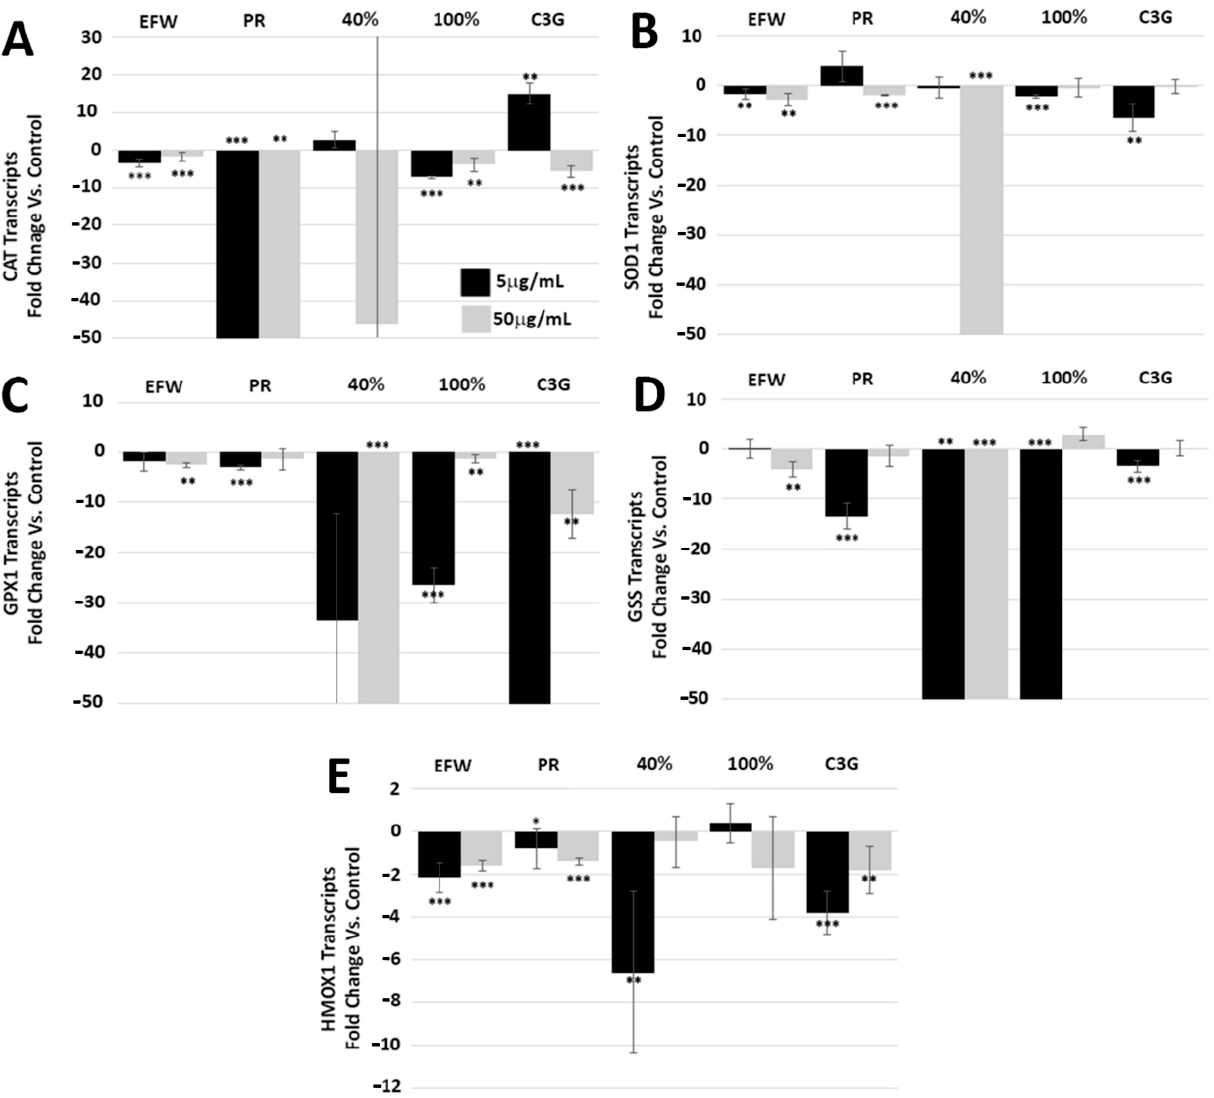
Figure 2. Specific Phenolic Fractions Decrease Antioxidant Transcript Levels. qRT-PCR quantification of transcripts encoding ( A ) CAT, ( B ) SOD1, ( C ) GPX1, ( D ) GSS and ( E ) HMOX1 following 72 h exposure of 2DD primary cells to EFW— ethanol:formic acid:water, PR—phenolic rich, 40%—40% ethanol fraction, 100%—100% ethanol fraction and cyanadin-3- O -glucoside at 5 µ g/mL (black bars) and 50 µ g/mL (grey bars). Graph values were cut off at 50-fold change vs. control. p -values = * p < 0.10, ** p < 0.05, *** p < 0.01 NOTE: quantified values are shown in Supplemental material Table S3.